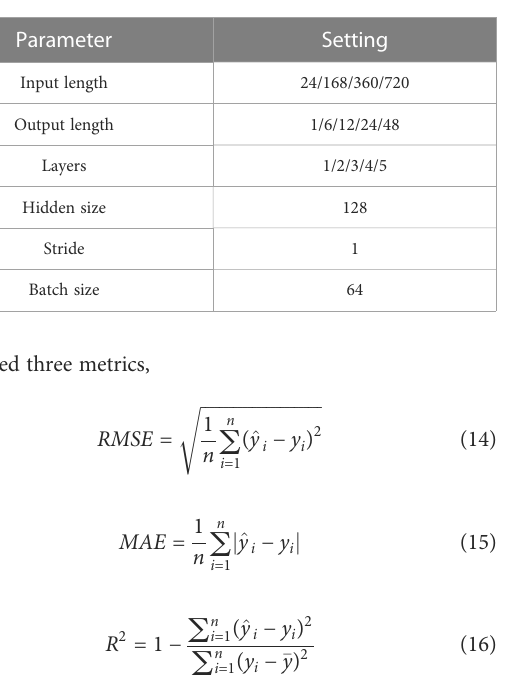
TABLE 1 Parameters setting.